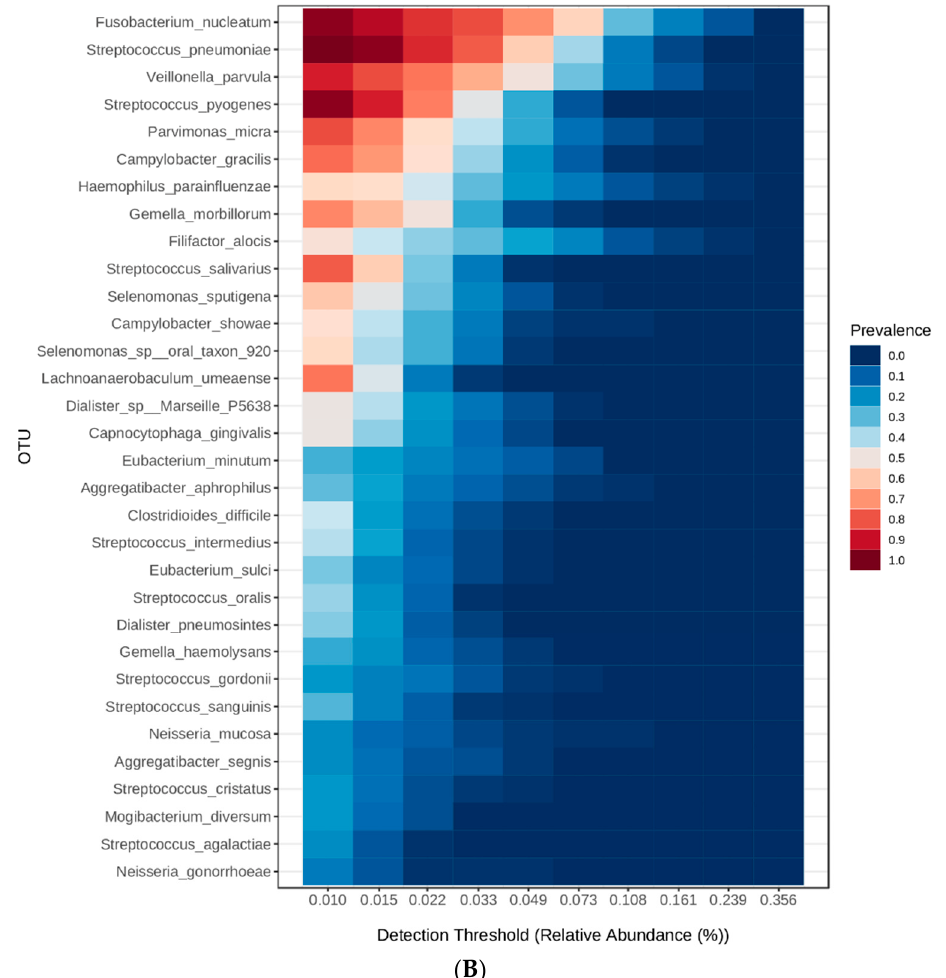
Figure 2. Heatmaps representing the core microbiome at genus level ( A ) and species level ( B ) detected among the study participants .